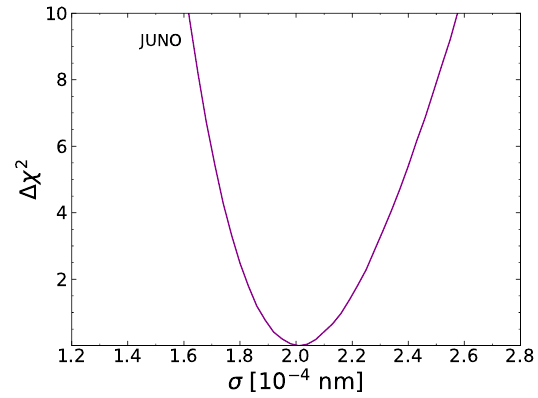
Figure 8 . The reduced (cid:31) 2 as a function of (cid:27) relative to its minimum value, obtained by analyzing simulated JUNO data consistent with strong decoherence ( (cid:27) = 2 : 01 (cid:2) 10 (cid:0) 4 nm) and marginalizing over all oscillation parameters. The input values for the standard solar oscillation parameters are listed in eqs. (2.5) while (cid:1) m 2 = 2 : 63 (cid:2) 10 (cid:0) 3 eV 2 and sin 2 (cid:18) 13 = 0 : 0231. See text for 31